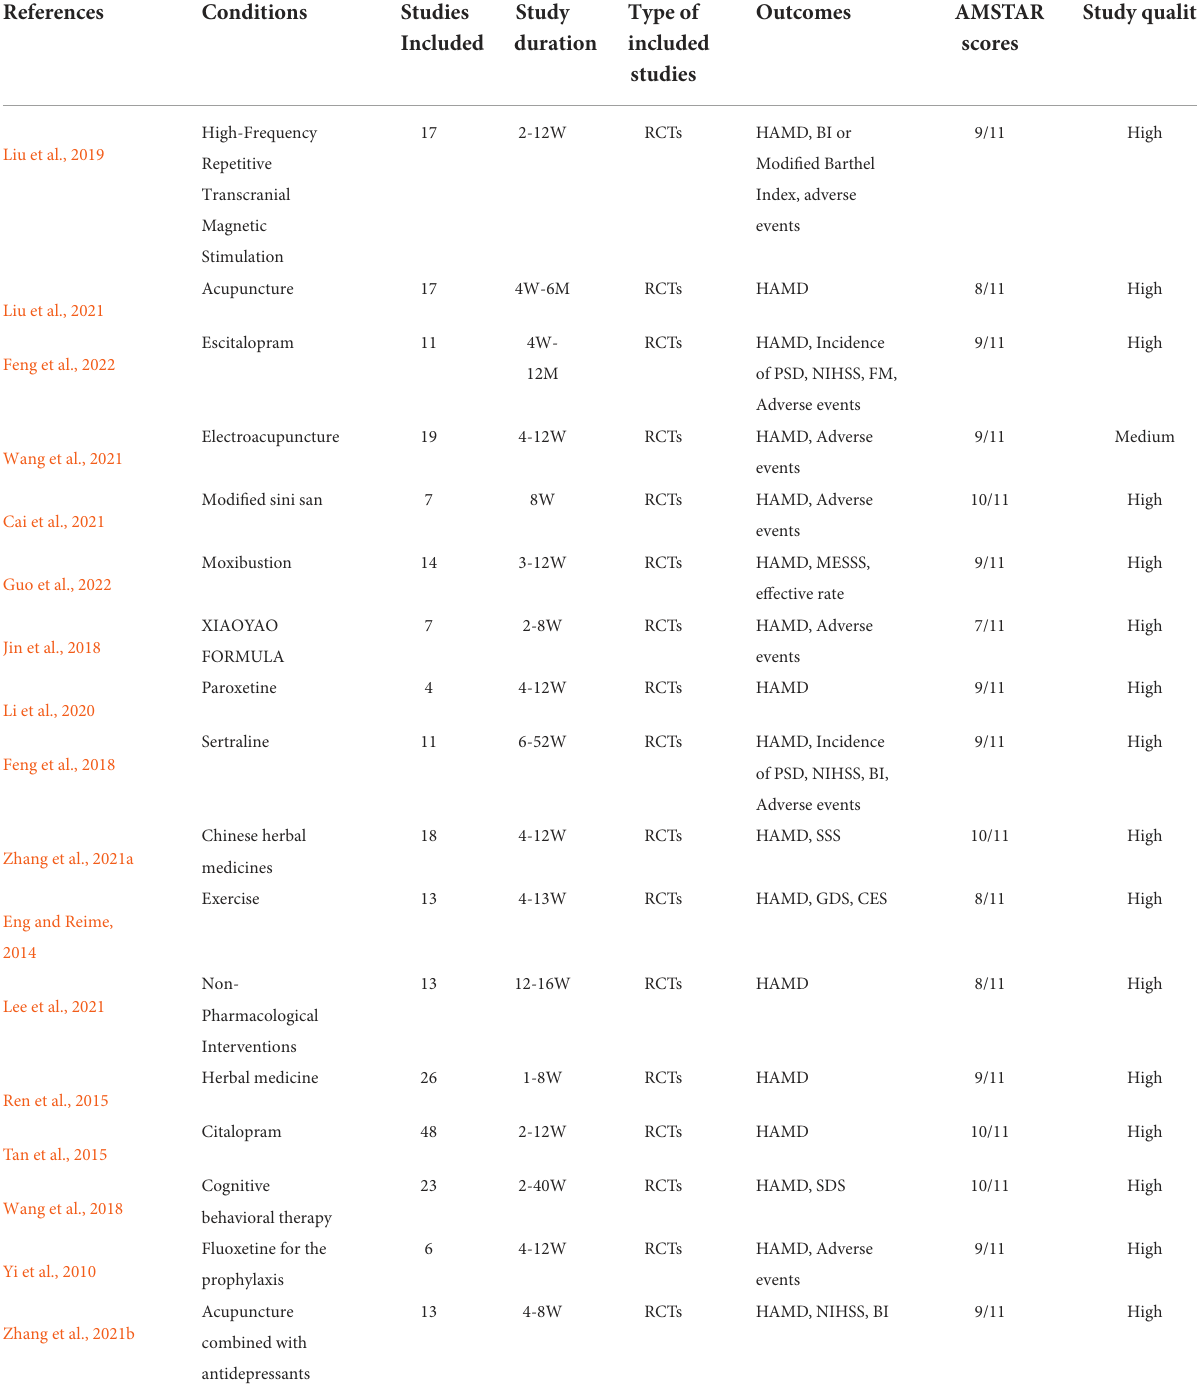
TABLE 1 Description of included